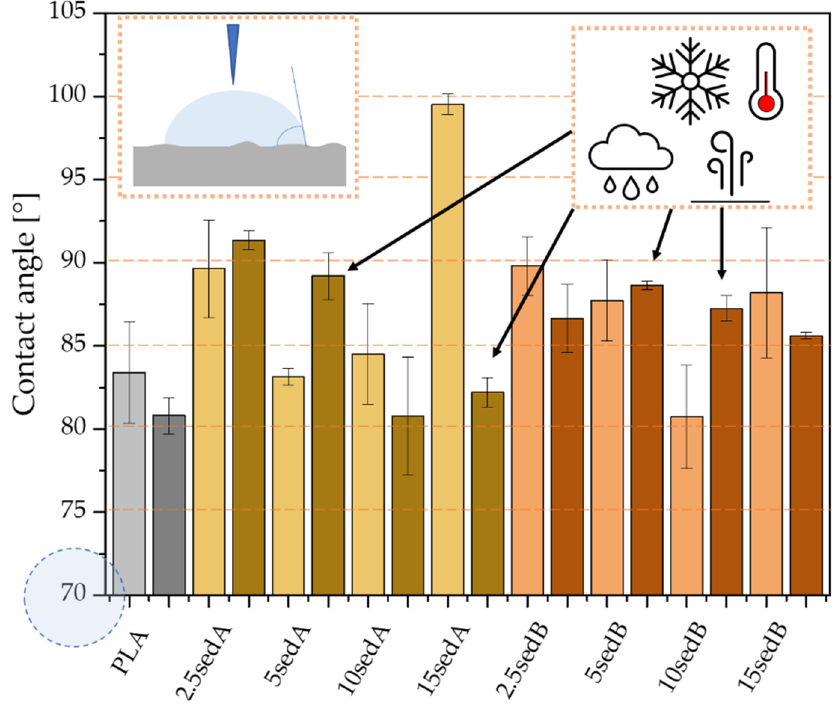
Figure 17. Contact angle for the composites PLA/sedA-B after conditioning in the weathering chamber (WCh).